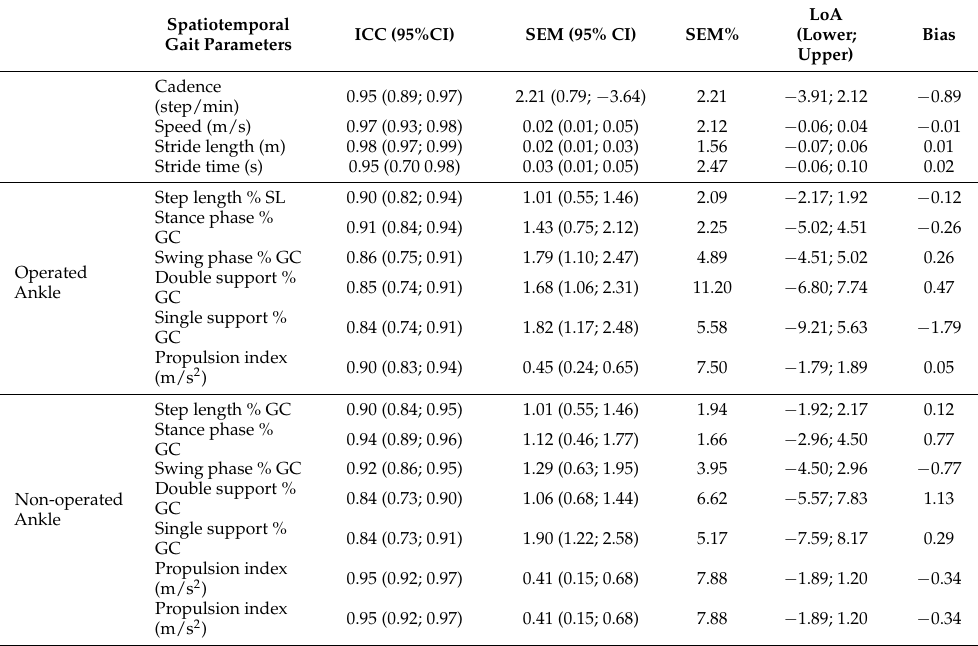
Table 5. Intra-session test–retest reliability spatiotemporal gait parameters with the G-WALK sensor. Limits of agreement (Bland–Altman analysis) and mean of the differences (bias) between two